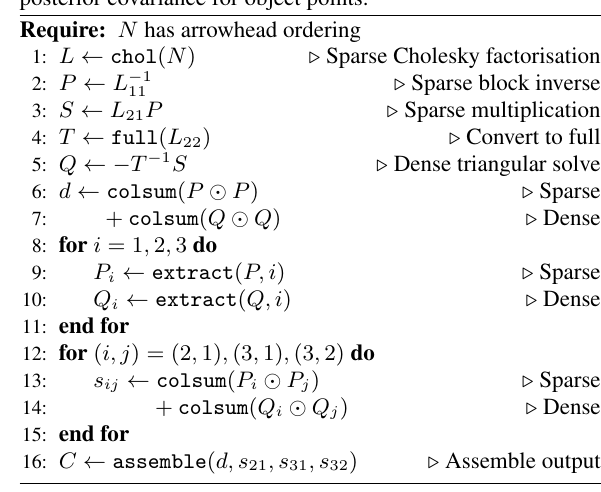
Algorithm 3 The legacy DBAT algorithm for computing poste- rior covariance for object